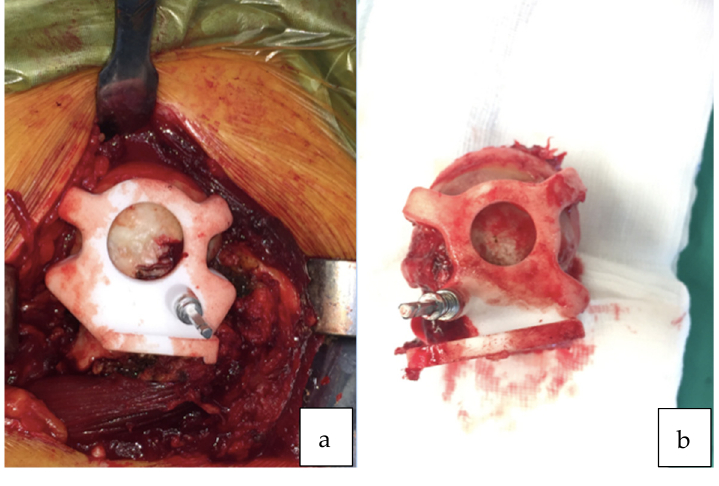
a b Figure 2. ( a ) Patient-specific femoral guide fitted to the proximal femur. ( b ) Femoral guide fitted to the proximal femur after the osteotomy cut.